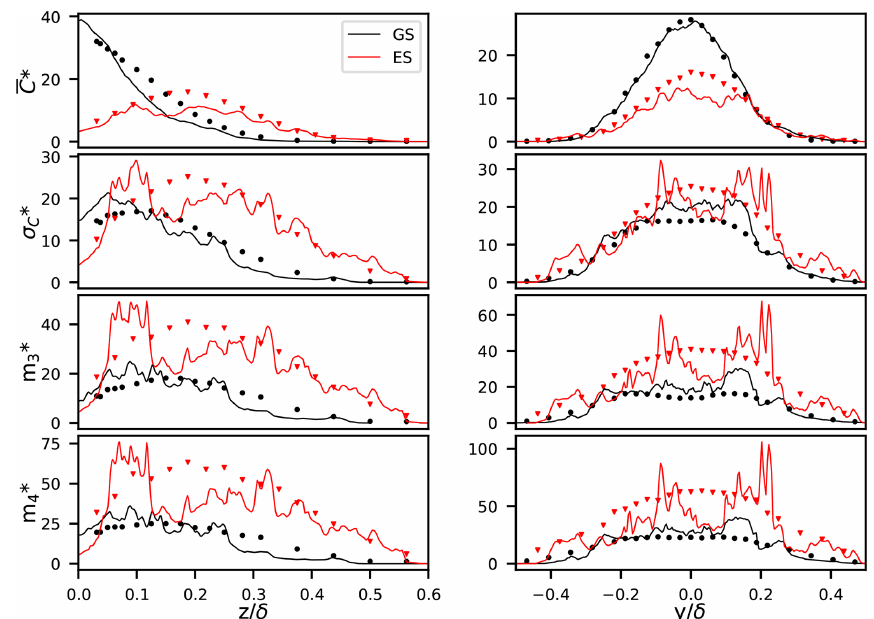
Figure 3. Vertical (left column) and horizontal (right column) profiles of the first four statistical moments of plume concentration. Lines denote LES results, and symbols are corresponding results from Nironi et al. (2015). GS (black) denotes the source emitted at 0.06 δ and ES (red) the source at 0.19 δ . The transects are taken at x N = 2.5 δ for the experiments. The corresponding values for x LES are 4.5 and 4.2 δ for GS and ES, respectively.